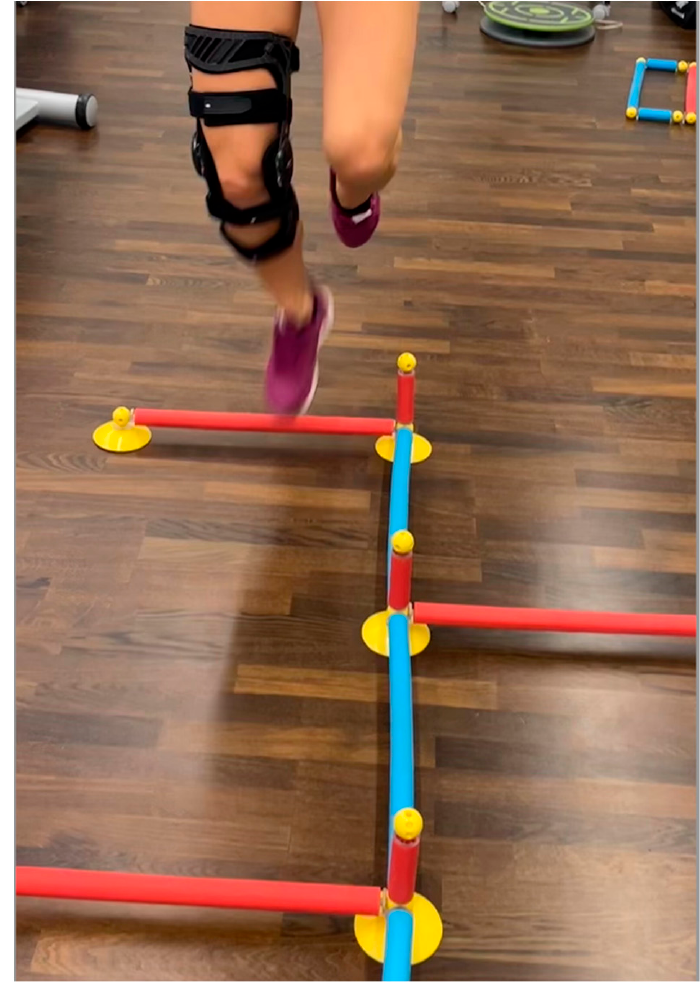
Figure 3. Speedy Jump Test.